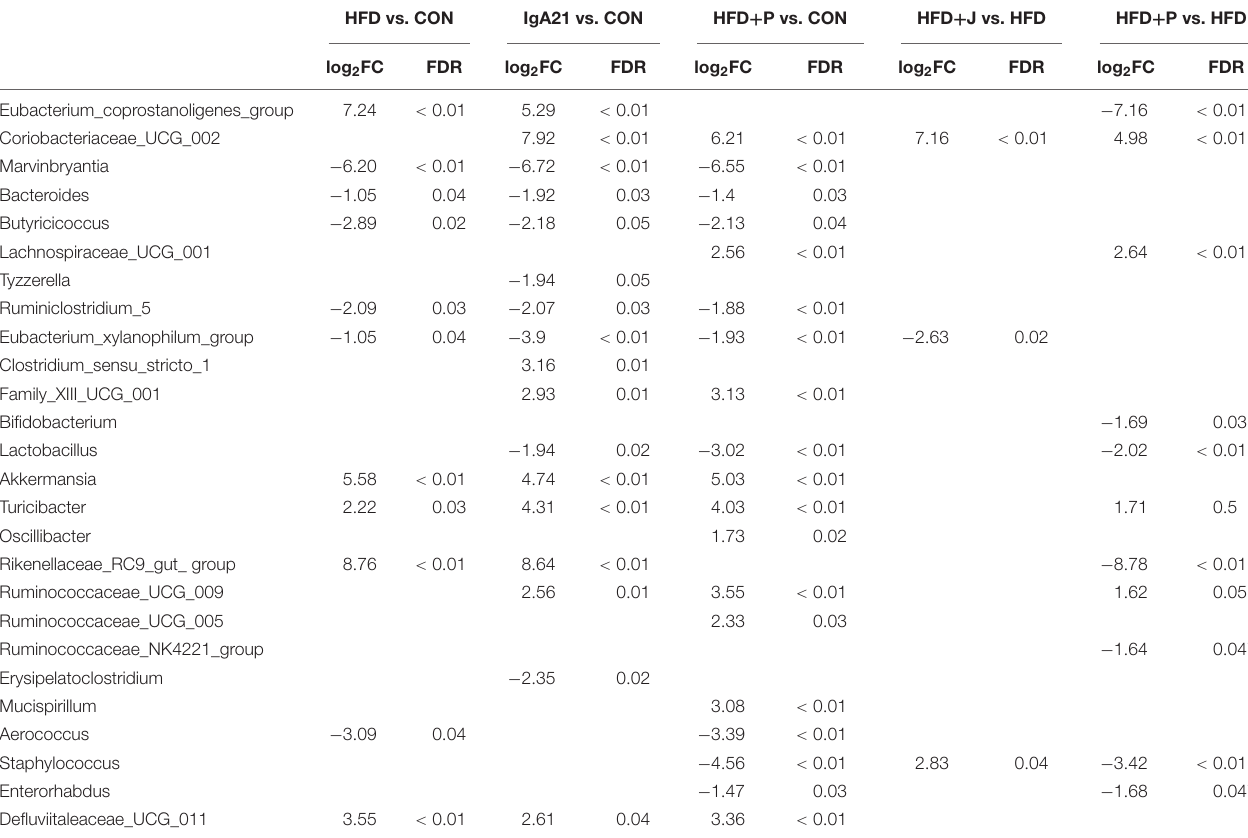
TABLE 2 | Significantly changed genus by comparison using log2 fold change. HFD vs. CON IgA21 vs. CON HFD + P vs. CON HFD + J vs.